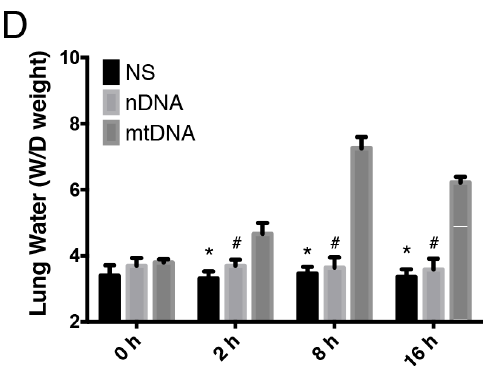
Figure 2. Intra-peritoneal administration of mtDNA leads to acute lung injury. WT mice were treated with NS, nuclear DNA (nDNA), or mtDNA via intra-peritoneal injection for 2, 8, and 24 h ( n = 16/group, 8 for bronchoalveolar lavage fluid ( BALF)). Acute lung injury was measure by hematoxylin and eosin (HE) staining (scale bar is 100 μ m) ( A ) for lung injury score ( B ); BALF total protein concentration ( C ); and lung W/D ratio ( D ) were also analyzed. * p < 0.05 versus mtDNA group; # p < 0.05 versus mtDNA group. Eight mice were used in each set and data are mean ± SEM of three separate experiments.